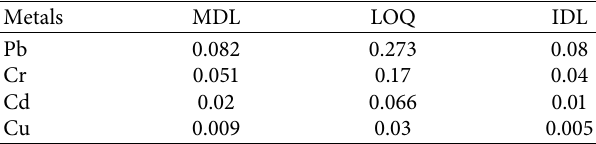
Table 4: Method detection limit and quantitation limit in mgL − 1 for the selected metals ( n � 9).